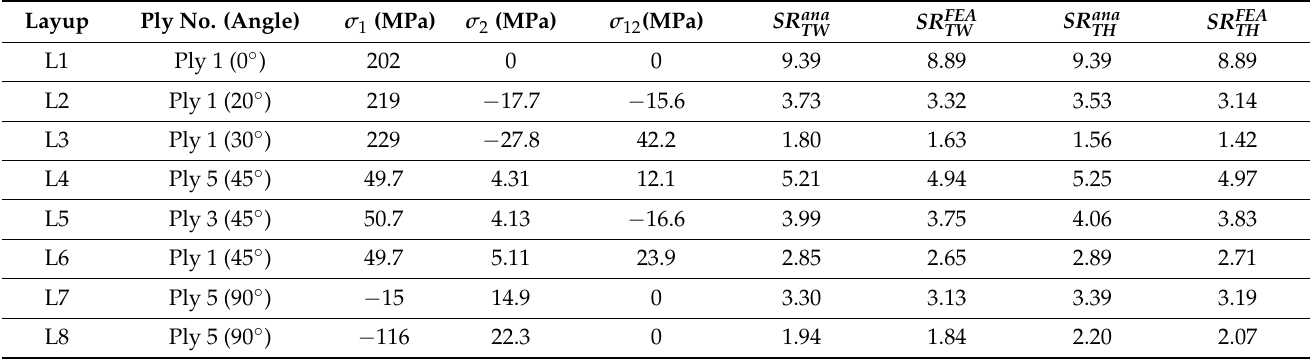
Table A3. Comparison of plies with minimum safety ratios (SRs) for the “III” beam (flange under tension; stress values are in MPa); see Figure 3c for a laminate stacking sequence